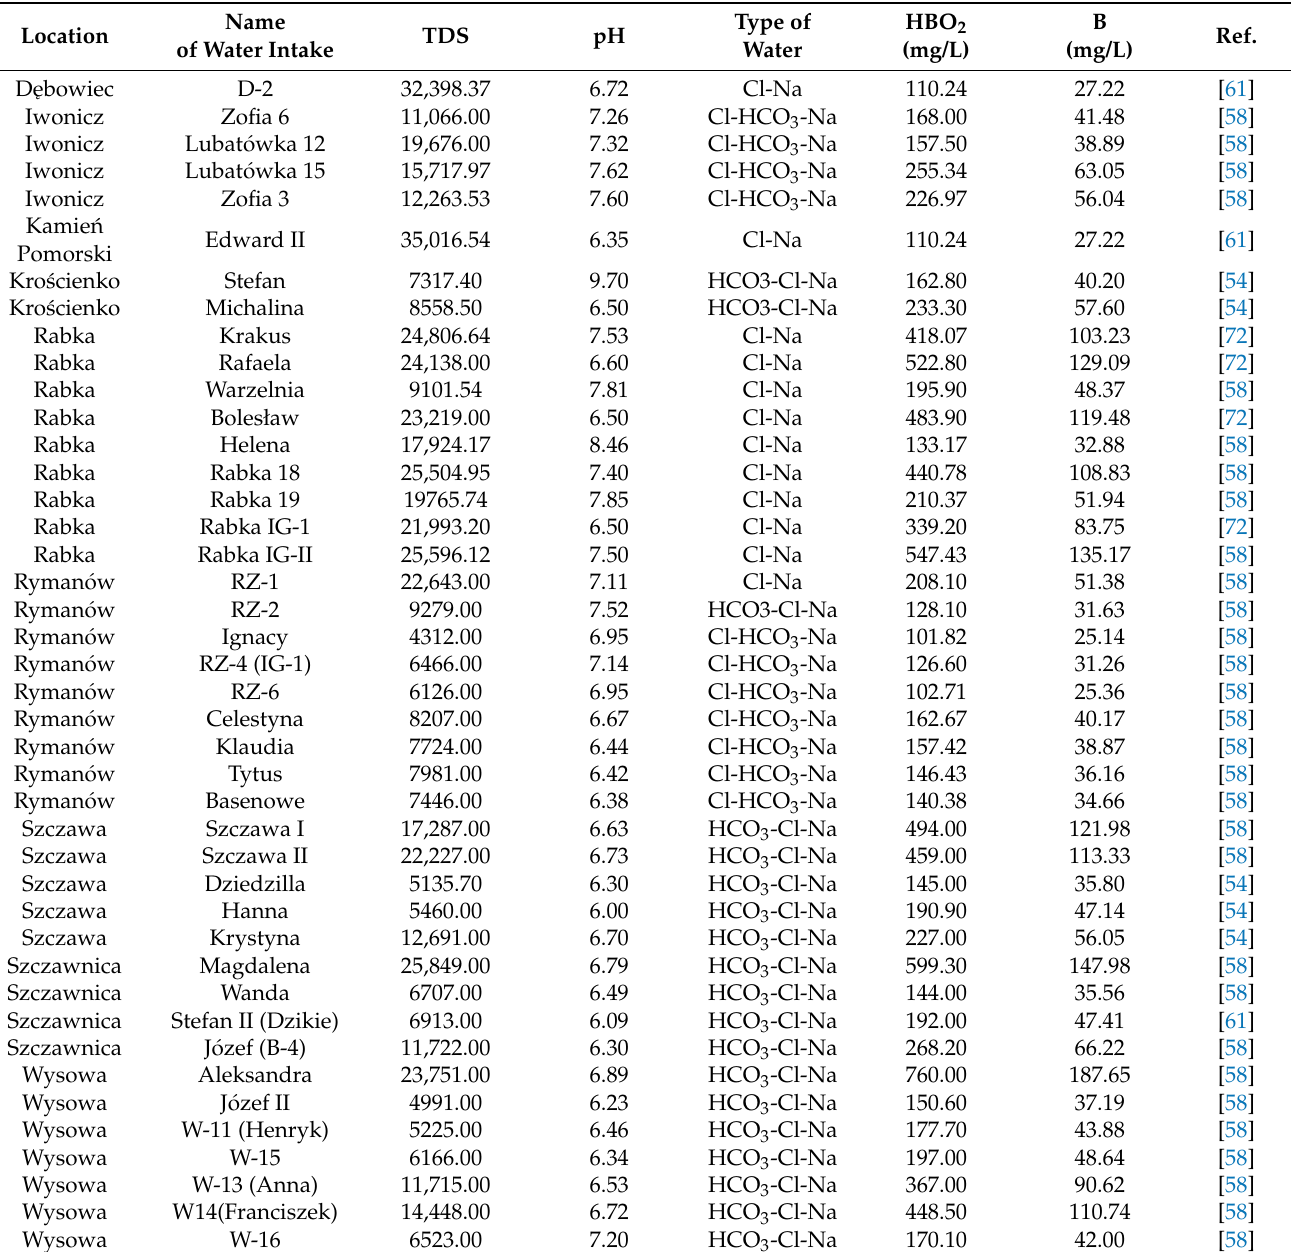
Table 2. Curative waters with boron concentrations above 25